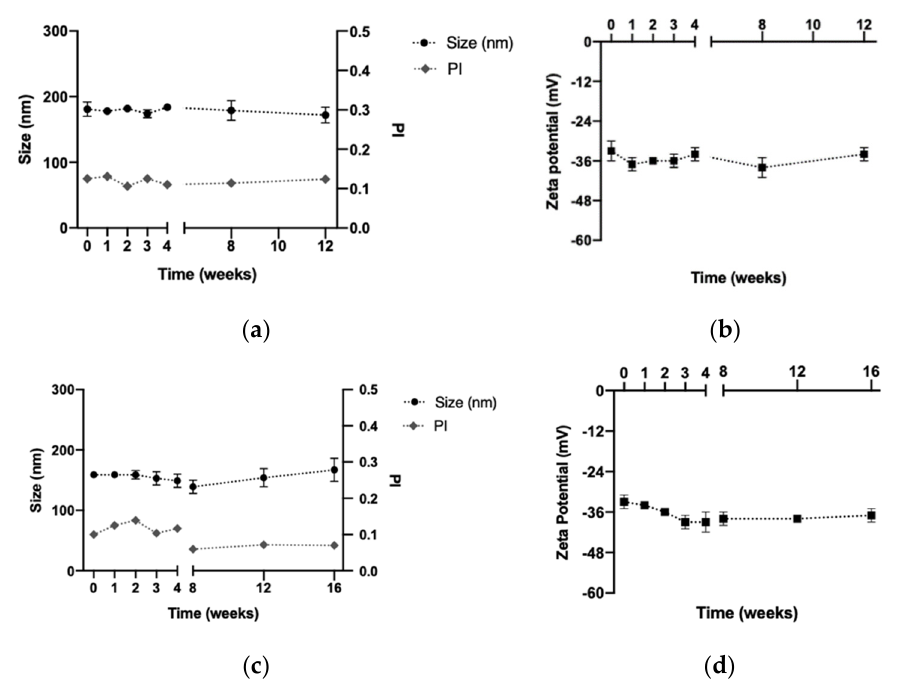
Figure 5. Stability of the dextran nanocapsules (DX NC*) with or without imiquimod in their core at 4 °C. Conditions: 4 °C. ( a ) Size and polydispersity index of DX NC*. ( b ) Zeta potential of DX NC*. ( c ) Size and polydispersity index of DX NC-imq*. ( d ) Zeta potential of DX NC-imq*. Imq: imiquimod. PI: polydispersity index. * Formulation elaborated applying high manual pressure. (Mean ± SD, n = 3).